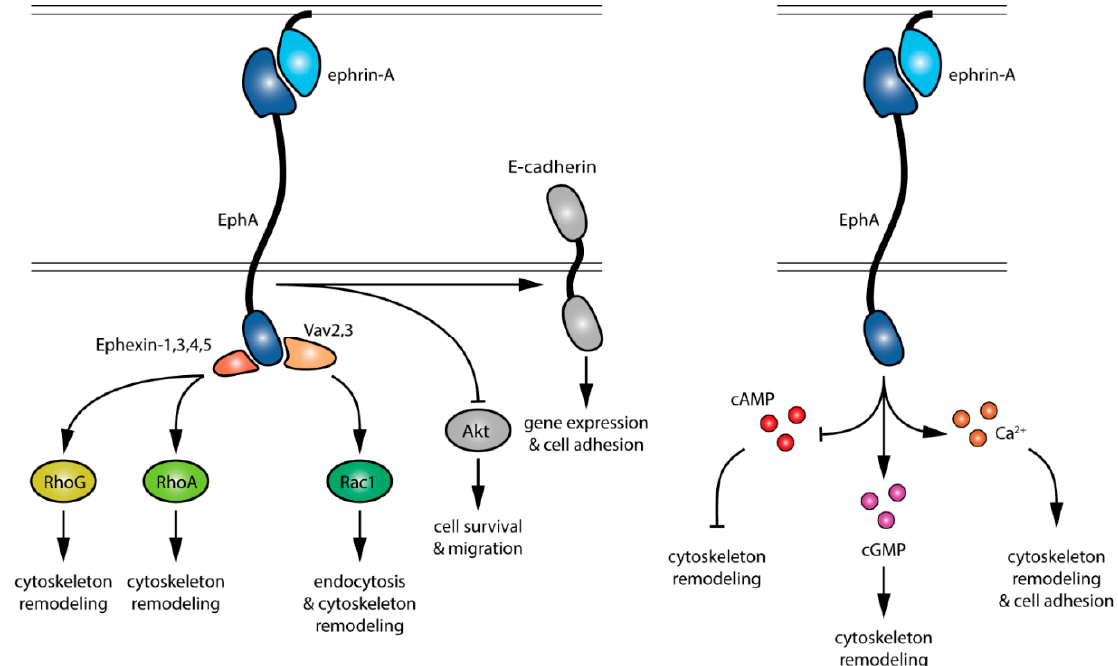
Figure 1. Signaling events downstream of EphA activation by ephrin-As. Pathways in gray are not detailed in this review.